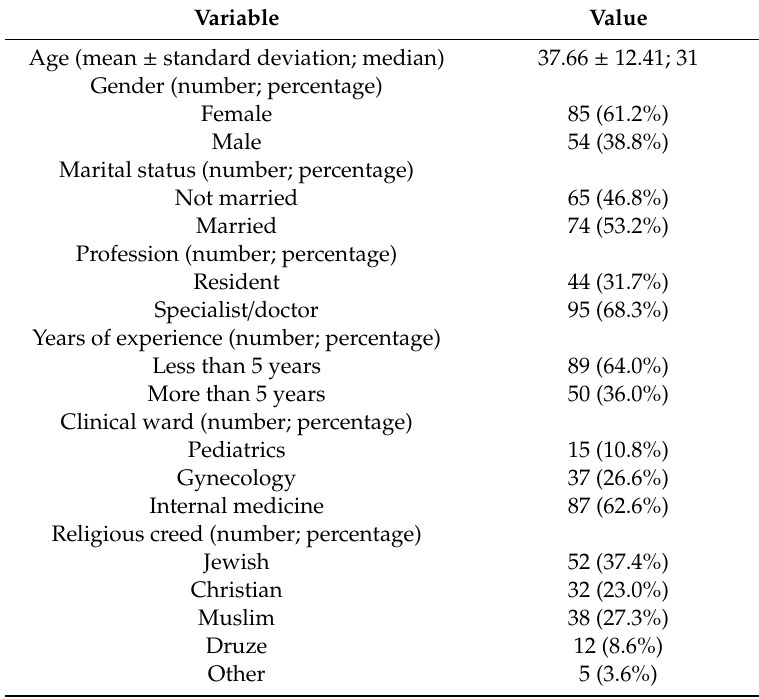
Table 1. Major characteristics of the sample recruited and included in the present study.